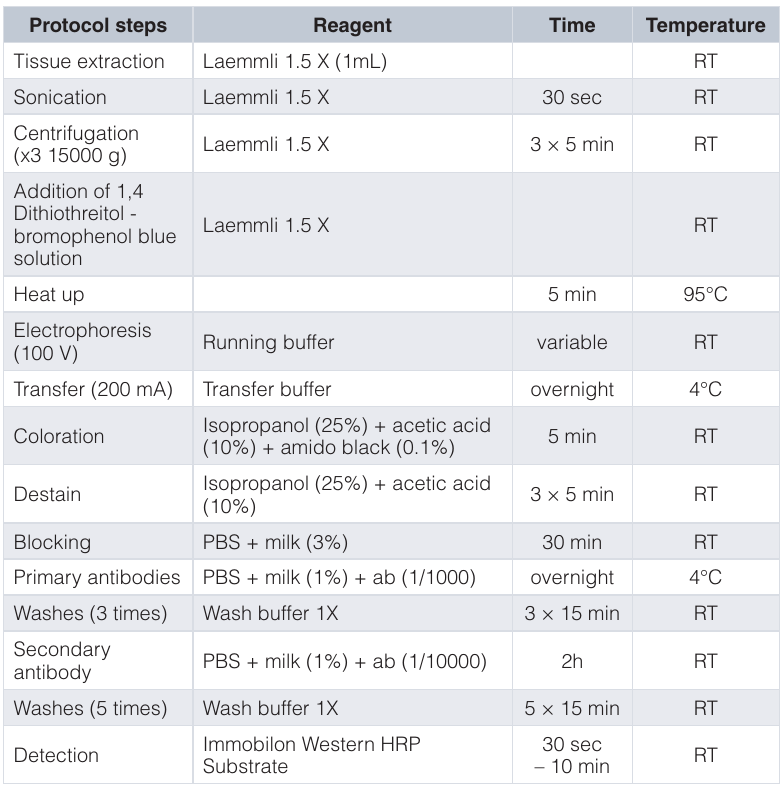
Table 3. Reagents for tissue extraction and western